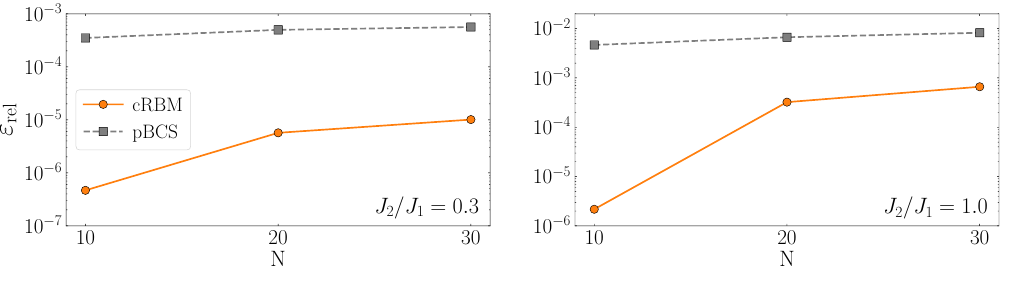
Figure 12: Size scaling of the relative error of the variational energy for the best- energy cRBM Ansatz with α comparison. Calculations are done for J panel) and N = 10, 20, and 30